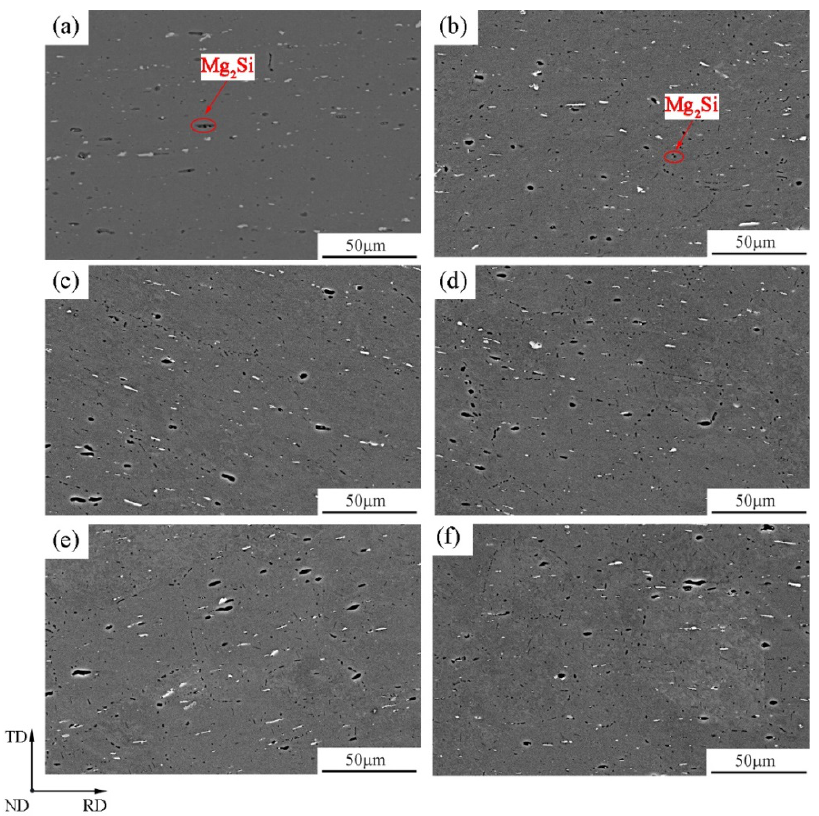
Figure 17. SEM micrographs of precipitate for AA6063 alloy samples before forming and in different observation positions of boss section after forming: ( a ) initial blank, ( b ) position A, ( c ) position B, ( d ) position C, ( e ) position D, and ( f ) position E.